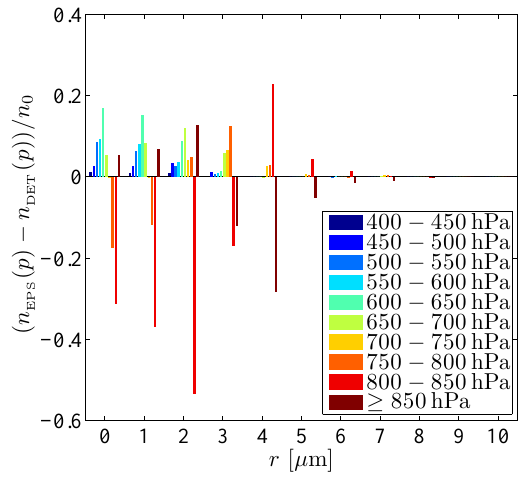
Fig. 4. The difference in the proportion of particles in the layers (colors) between the ensemble mean and the deterministic forecast for r = 0 − 10 µ m .